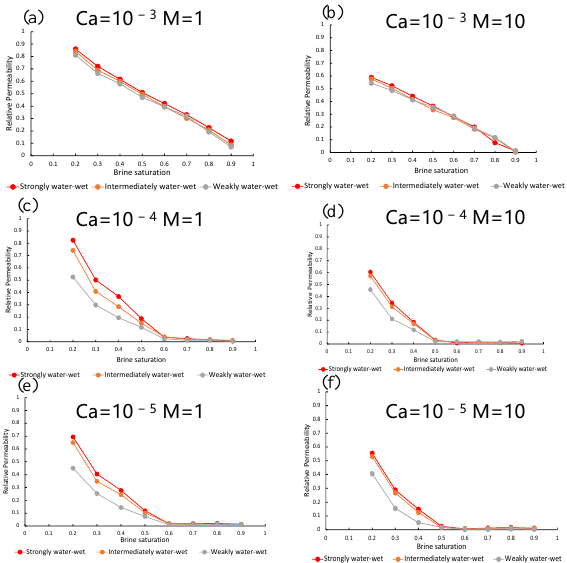
Figure 16. Simulated relative permeability curves for CO 2 (nonwetting) under the total 18 scenarios, with different combinations of three nondimensional parameters including capillary number ( Ca ), wettability index ( WI ) and viscosity ratio ( M ) described in Table 1. ‘ W ’, ‘ In ’ and ‘ S ’, respectively represent weakly water-wet ( WI = 0.3); intermediately water-wet ( WI = 0.7); and strongly water-wet ( WI = 0.9). (Note: ( a ) and ( b ) represent cases under high capillary number ( Ca = 1 × 10 − 3 ), while those under low capillary numbers ( Ca = 1 × 10 − 4 , Ca = 1 × 10 − 5 ) are done by ( c – f